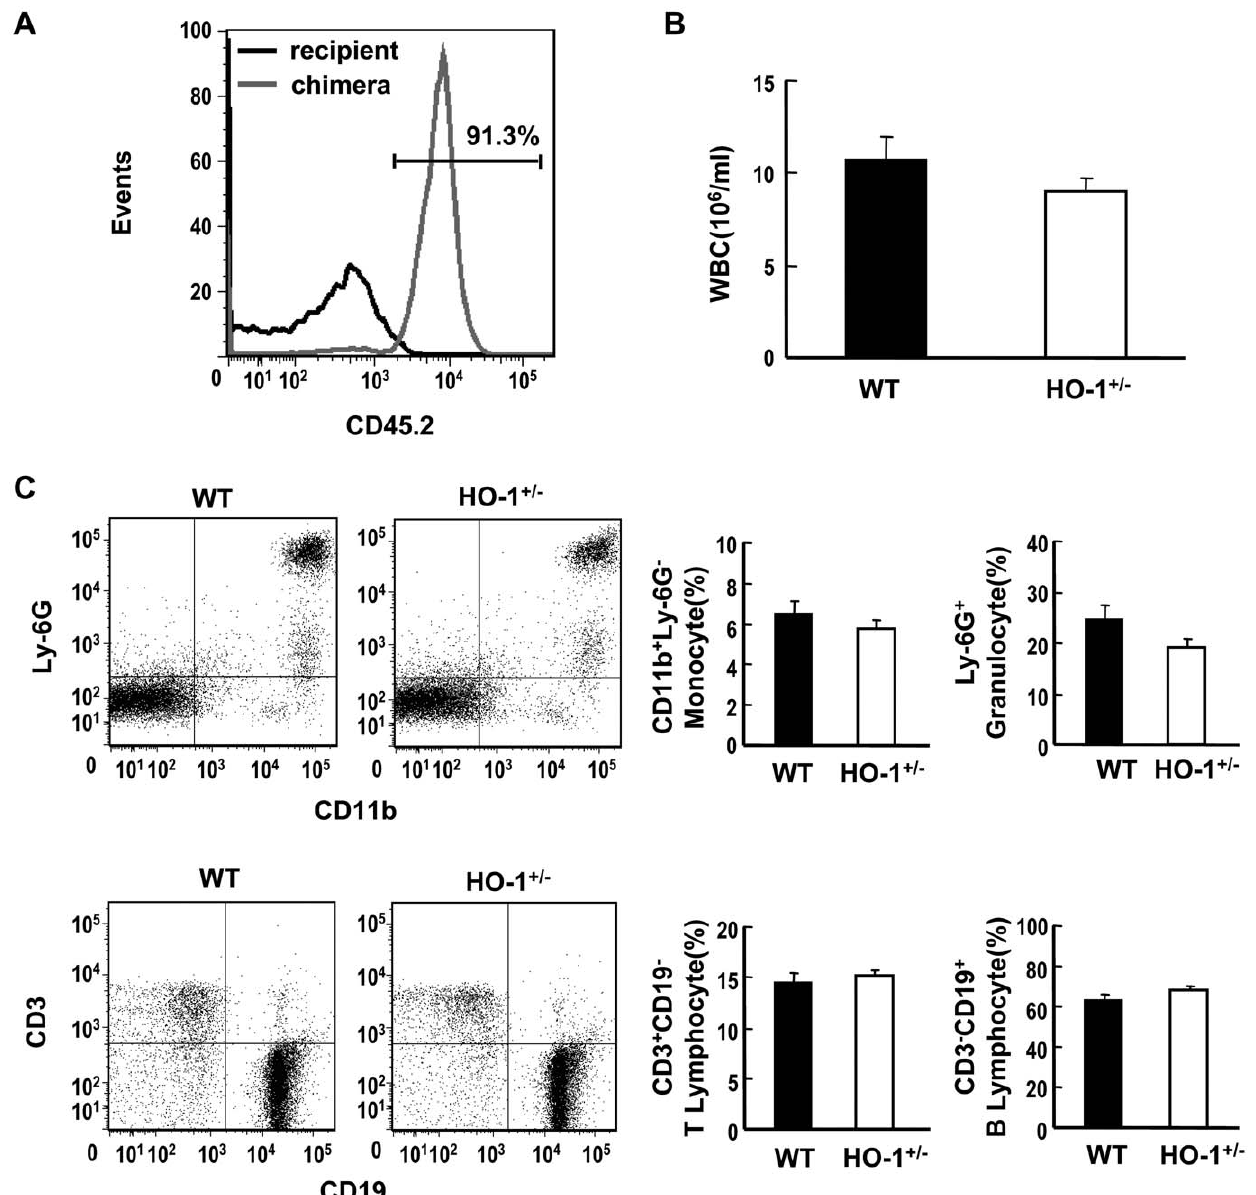
Figure 2. Generation of hematopoietic HO-1 + / 2 chimeric mice. A, C57BL/6 mice (B6.SJL- Ptprc a Pepc b /BoyJ ) expressing CD45.1 alloantigen (Ly5.1) on the surface of circulating leukocytes were lethally irradiated, followed by transplantation of bone marrow cells isolated from C57BL/6J mice expressing CD45.2. After 4 weeks, whole blood were collected from chimeric mice and analyzed for the expression of CD45.2 by flow cytometry. The blood cells isolated from un-irradiated recipient mice were used as control. Data shown is a representative of 3 mice with independent BMT. B, C57BL/6J mice were lethally irradiated and received transplantation of bone marrow cells isolated from WT and HO-1 + / 2 mice. At 4 weeks after BMT, peripheral blood was collected and white blood cell count was determined. The number of mice in each chimeric group is five. C, The percentages of various blood cell types were analyzed by flow cytometry. The number of mice analyzed in each group is five.